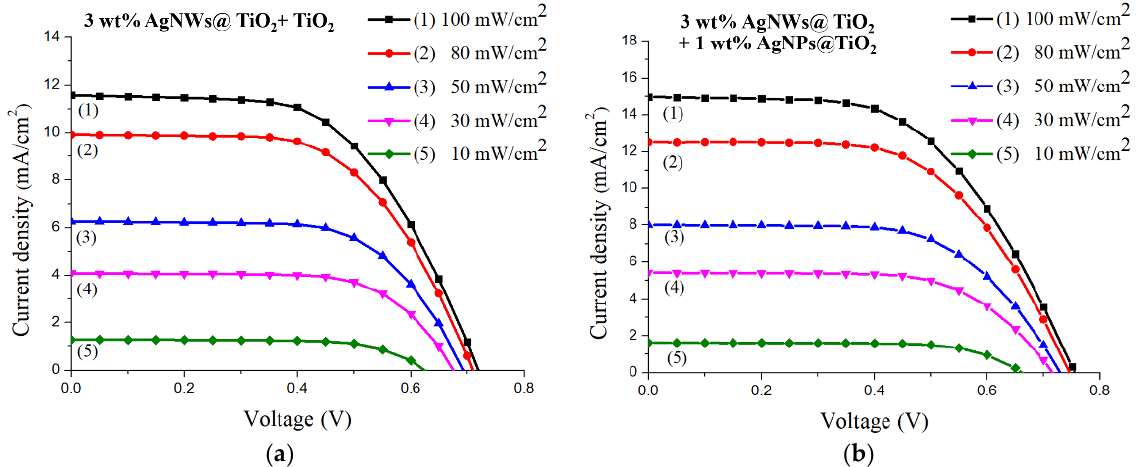
Figure 9. J-V curves of DSSCs under different light intensities. ( a ) 3 wt% AgNWs@TiO 2 /TiO 2 and ( b ) 3 wt% AgNWs@TiO 2 /1 wt% AgNPs@TiO 2 . Table 3. Photovoltaic parameters of different photoanodes under different light intensities.